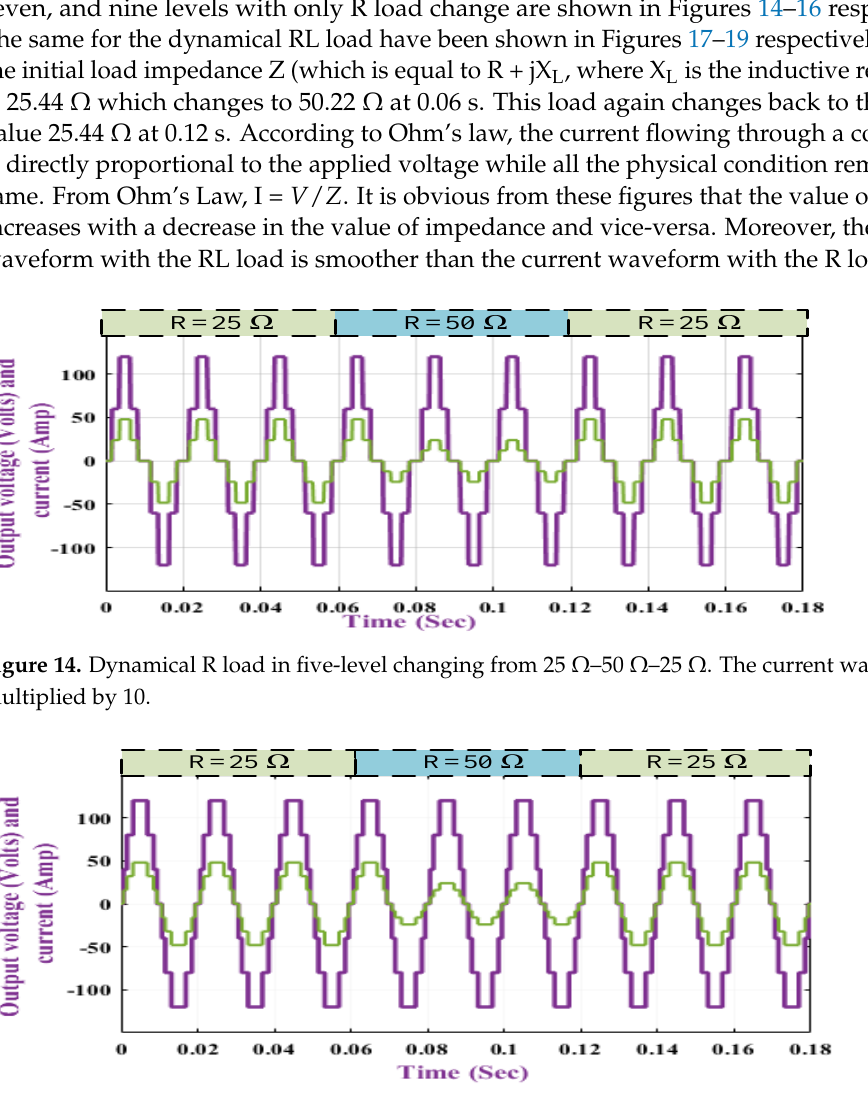
Figure 15. Dynamical R load in seven-level changing from 25 Ω–50Ω– 25 Ω. The current waveform is multiplied by 10.